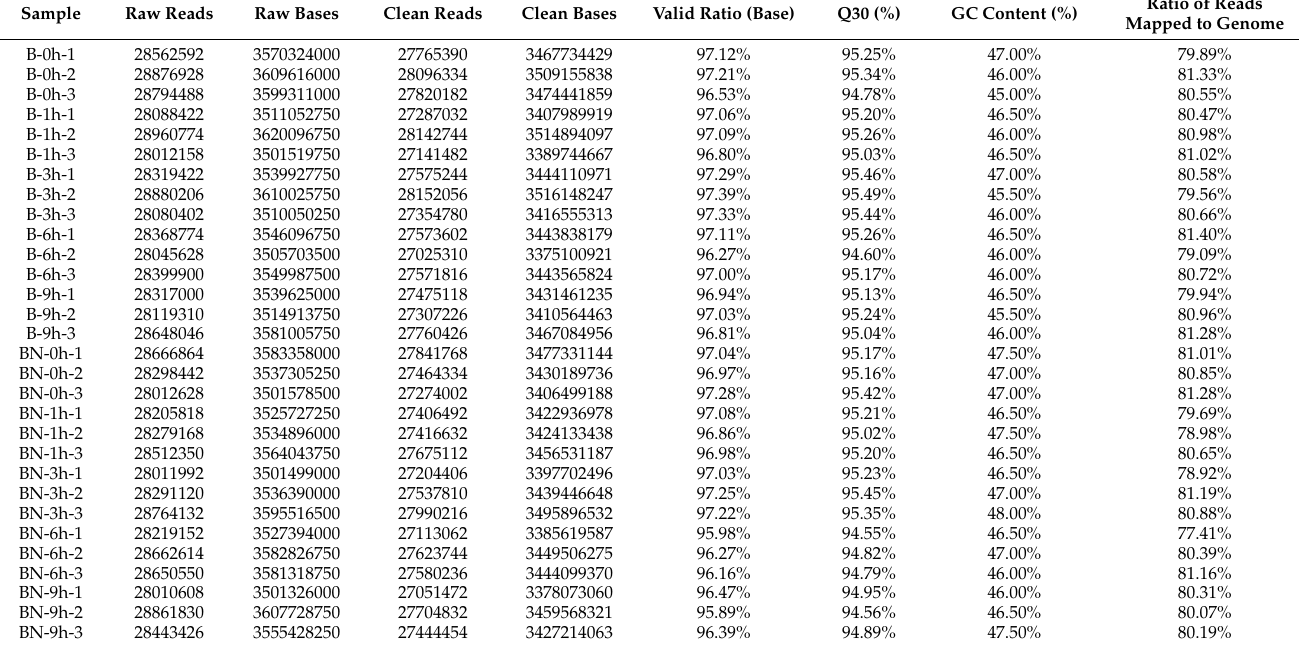
Table 2. Summary of RNA-seq